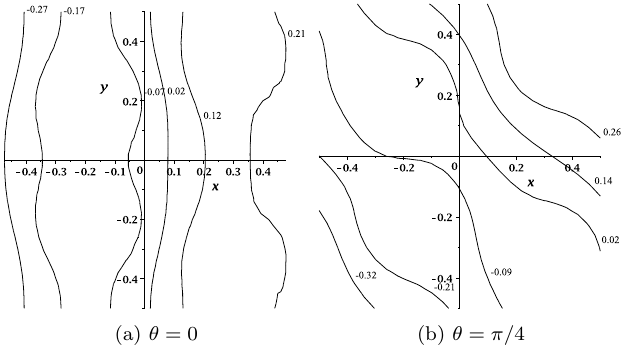
Figure 5. The temperature distribution inside Q (0 , 0) for λ k = 0 . 01, γ k = 100, β k = − 100, θ = 0; π/ 4.